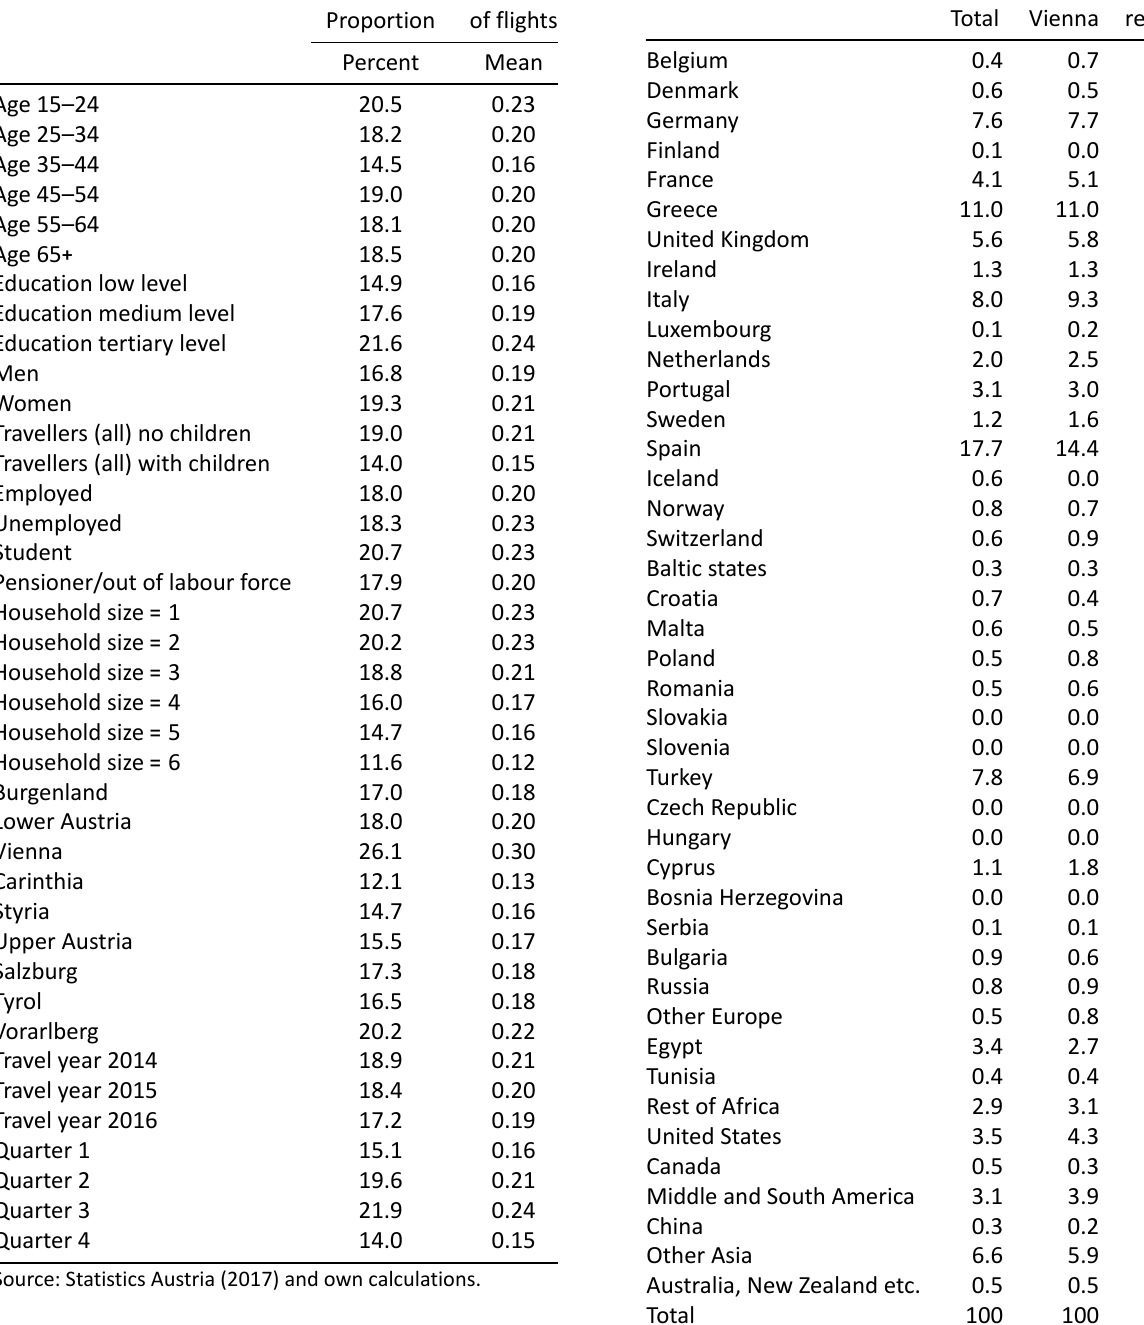
Table 3. Choice of holiday flight destination by residence, pooled 2014–2016 (percent).